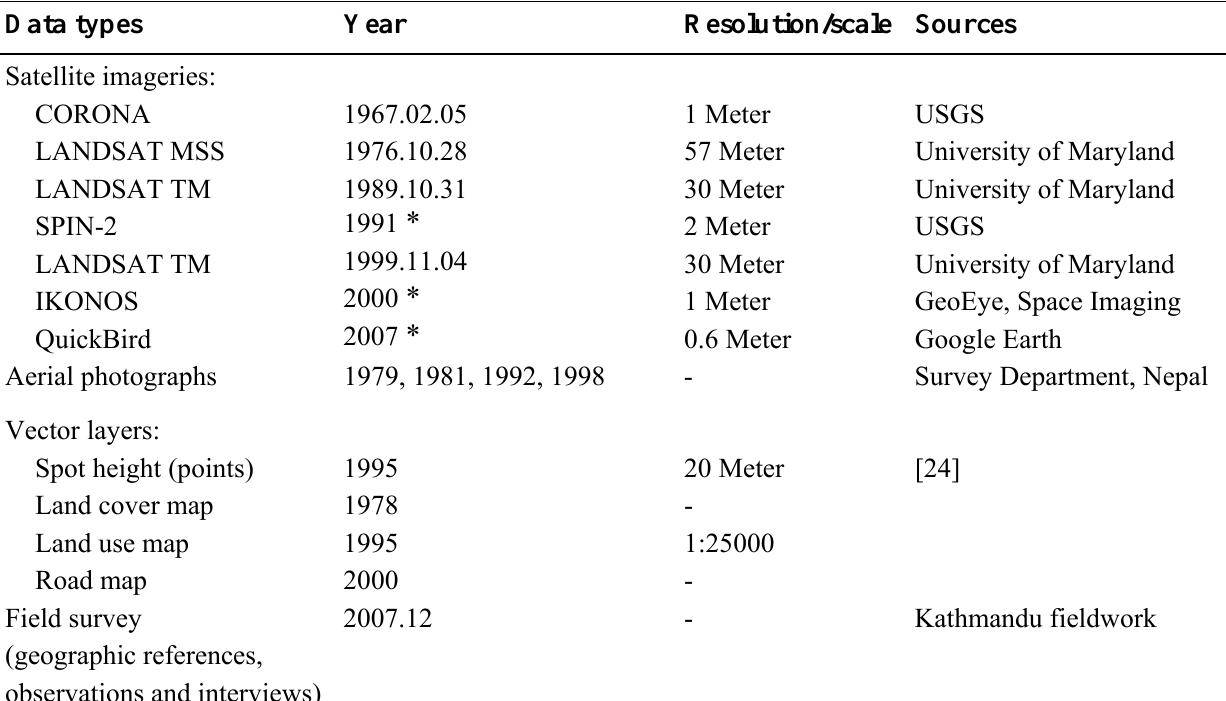
Table 1. List of databases used in this